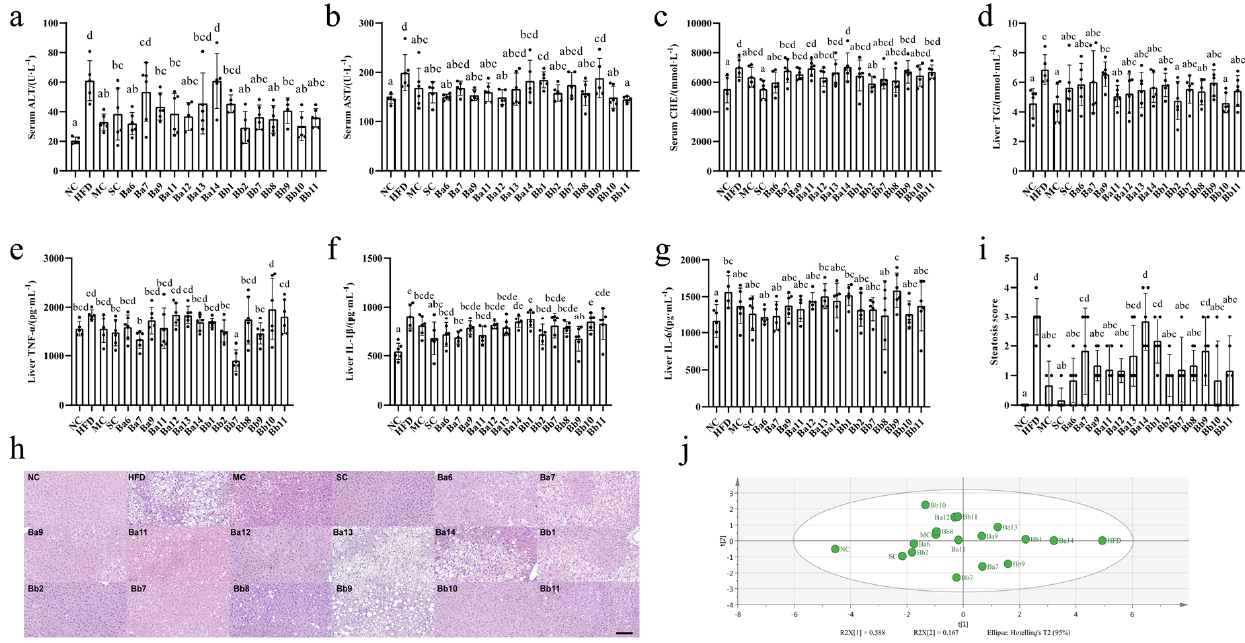
Figure 1. The effect of Bifidobacterium on liver injury in NAFLD mice. ( a ) ALT in serum; ( b ) AST in serum; ( c ) CHE in serum; ( d ) TG in liver; ( e ) TNF- α in liver; ( f ) IL-1 β in liver; ( g ) IL-6 in liver; ( h ) Liver histopathology score, ( i ) Principal Component Analysis of each index of liver injury. ( j ) Principal com- ponent analysis of each index. Mean values with different letters (a–e) over the bars are significantly different ( p < 0.05) according to Duncan’s multiple range